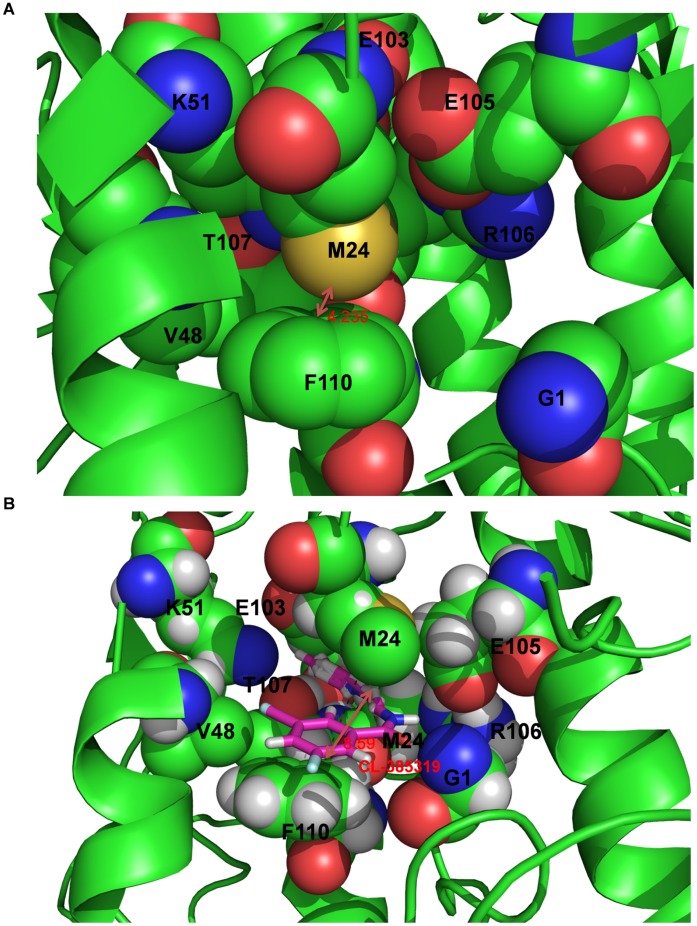
The averaged distance between residue F1102 and residue M241.A) The initial conformation of CL-385319-hemagglutinin complex. B) The averaged conformation of CL-385319-hemagglutinin complex over MD simulation.